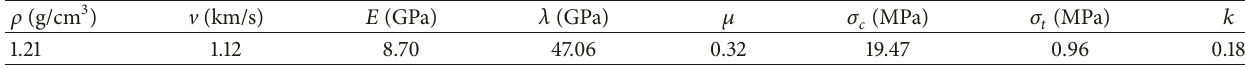
Table 1: Basic physical and mechanical parameters of the coal specimen.